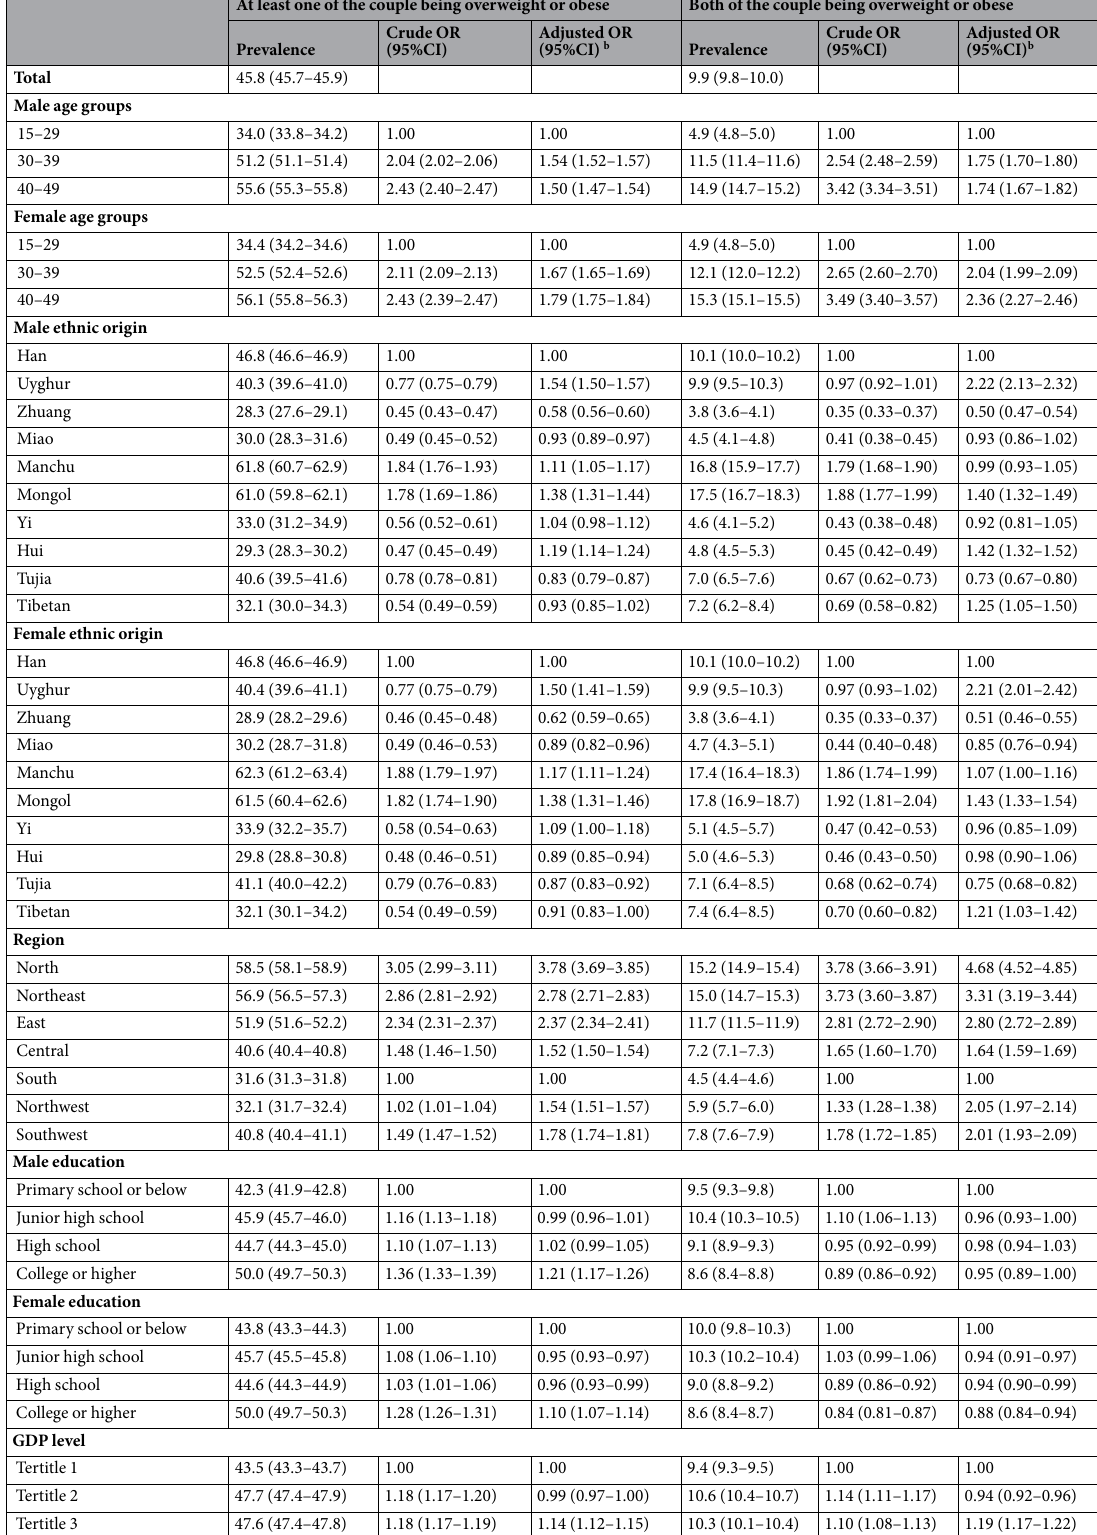
Table 4. Clustering of overweight and obesity for reproductive-age couples in rural China, 2010–2014 a . OR, odds ratio; CI, confidence interval. a Data are shown as prevalence (95% confidence interval), and all estimates were weighted using the China Population Census in 2010. Overweight and obesity were defined according to the Chinese criteria: overweight, 24.0 ≤ BMI ≤ 27.9 kg/m 2 and obesity, BMI ≥ 28.0 kg/m 2 . b Adjusted for all other factors in the